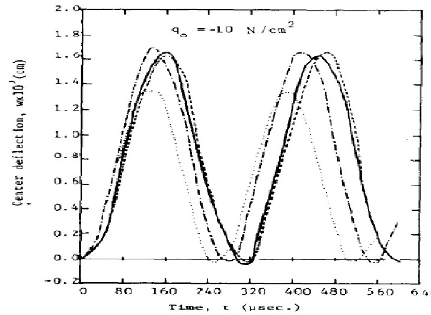
Figure 8. Response of a simply supported plate subjected to a step pressure load ( ---- Akai; ____ FEM; … plate